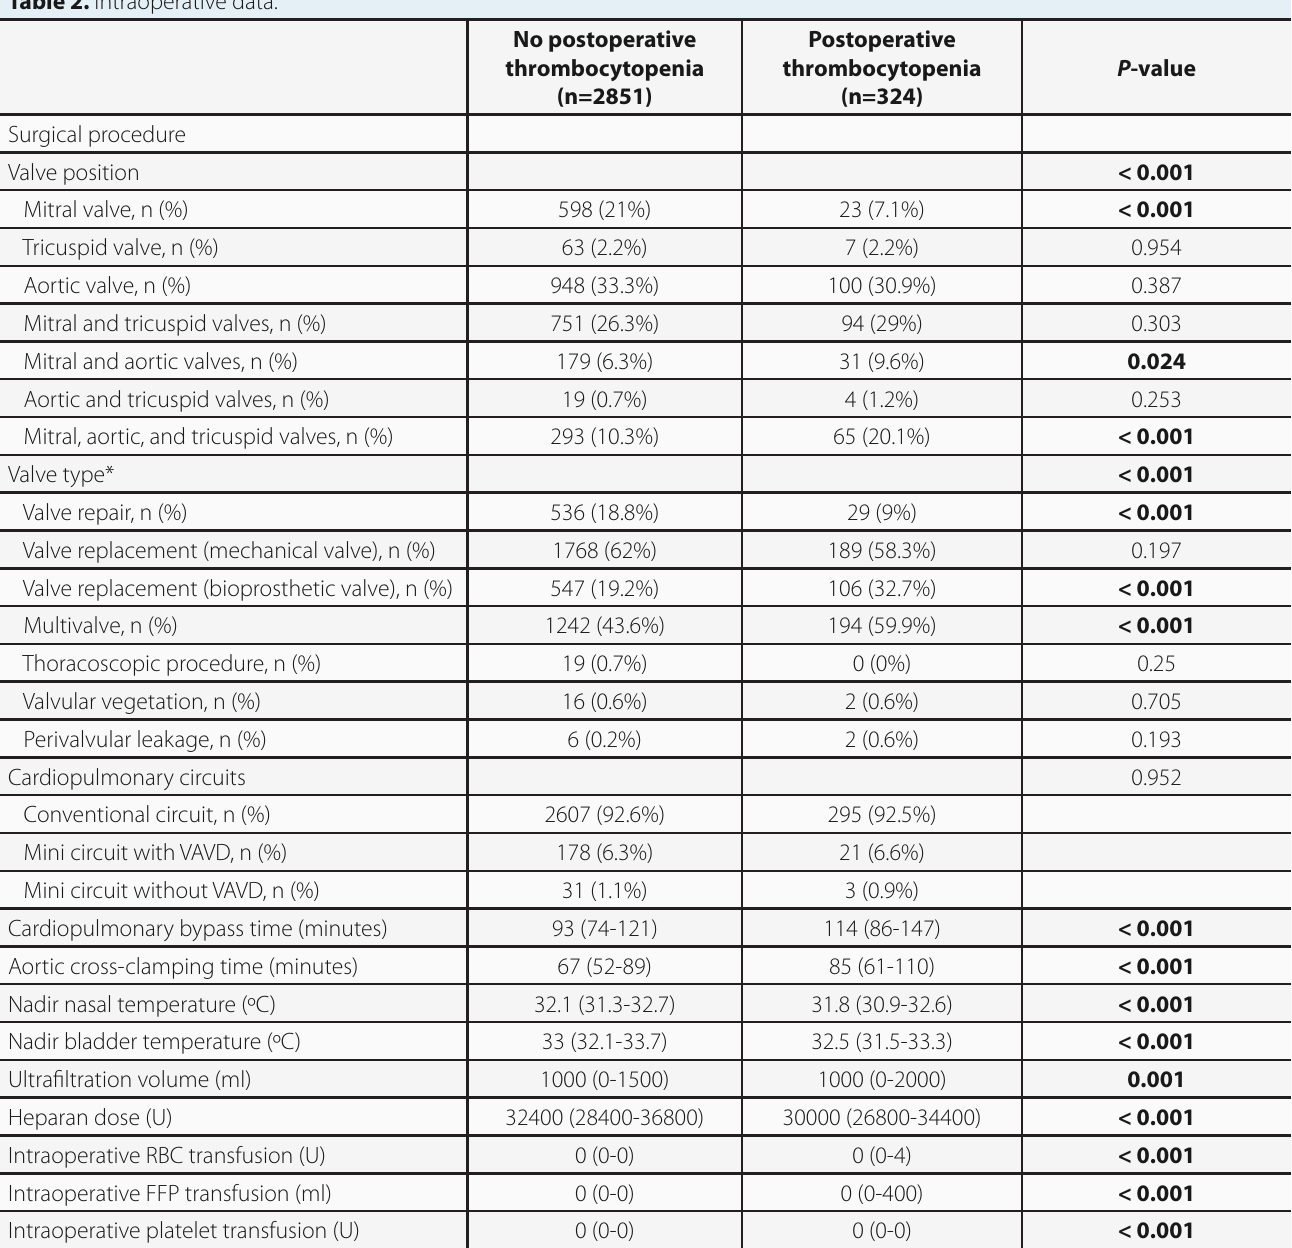
Table 2. Intraoperative data.